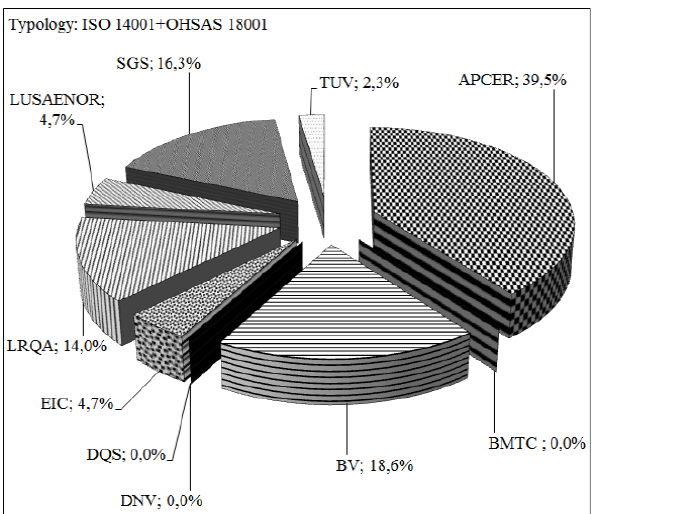
Figure 10. Relevant certification bodies involved with the ISO 14001+OHSAS 18001 integrated